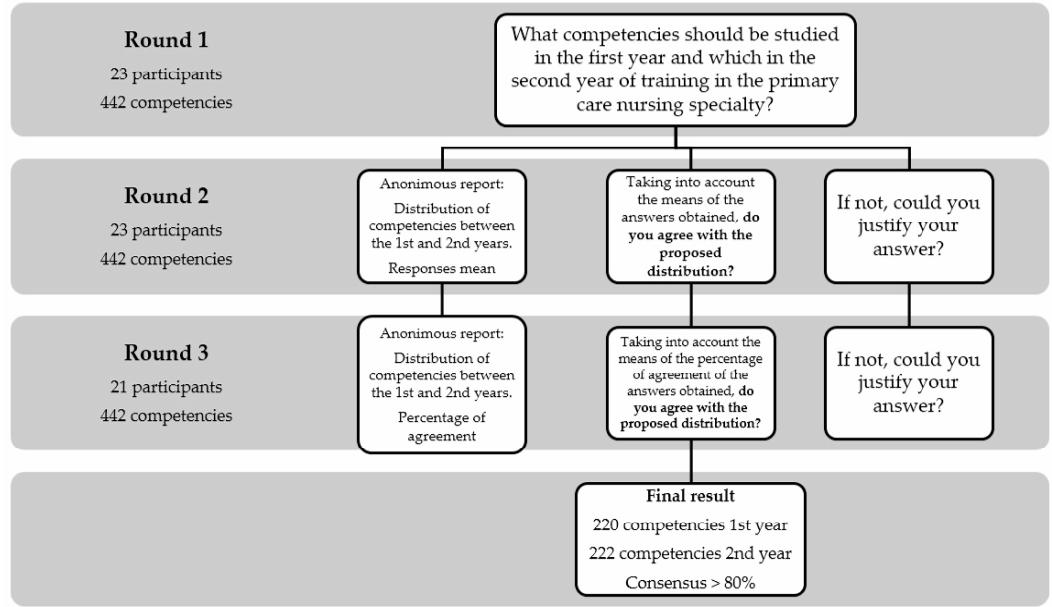
Figure 2. Flow chart of the Delphi research method